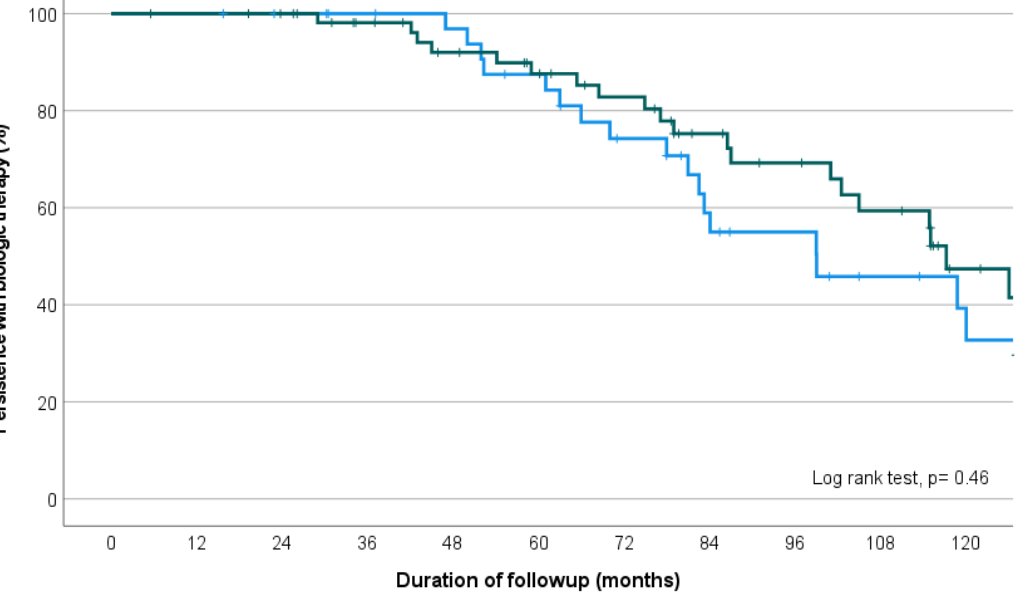
Figure 4. Kaplan–Meier survival curve depicting proportion of treatment persistence on infliximab then adalimumab/golimumab (green line), versus adalimumab then infliximab/golimumab (blue line), over the study follow-up period.